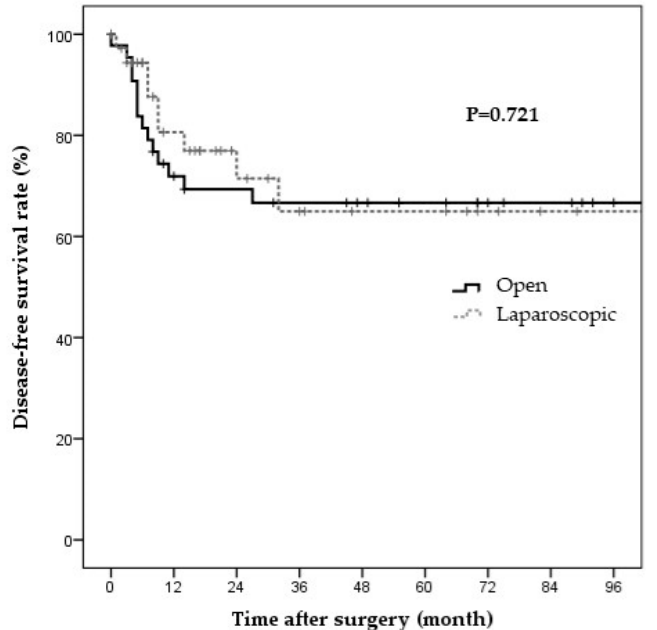
Figure 1. Disease-free survival in the T2 GBC patients by surgery type. The disease-free survival rate in the propensity-score-matched patients at three years was 65.0% and 66.7% in the laparoscopic and open surgery groups, respectively. The two groups showed no significant difference in recurrence ( p = 0.721).